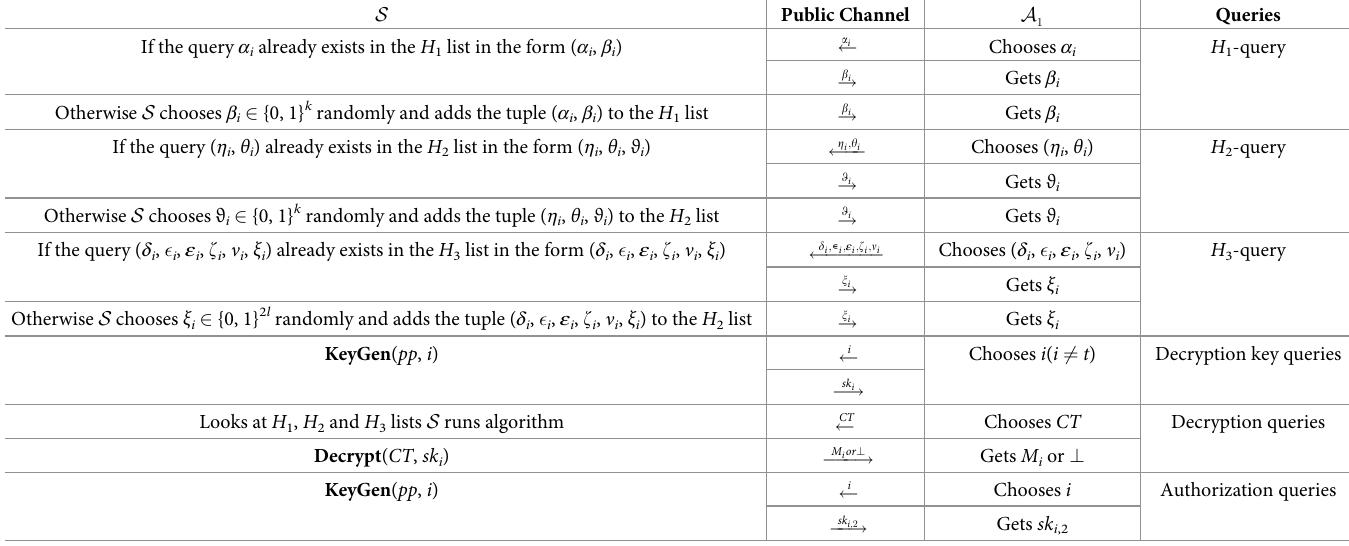
Table 3. Phase1 of Game